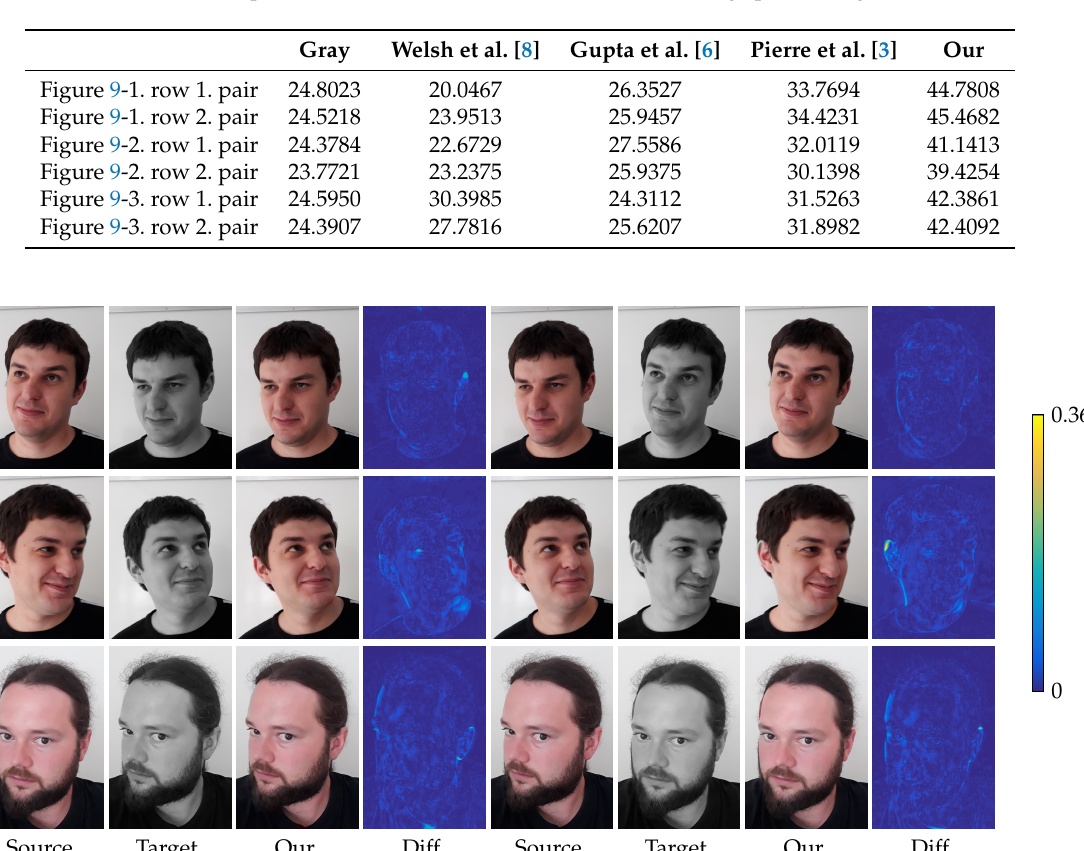
Table 2. Comparison of the different PSNR values for the image pairs in Figure 9.